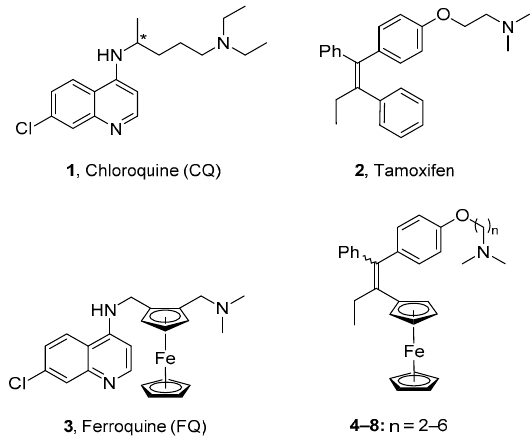
Figure 1. Chemical structures of chloroquine ( 1 ), tamoxifen ( 2 ) and their ferrocenyl derivatives ferroquine ( 3 ) and ferrocifens ( 4–8 ).